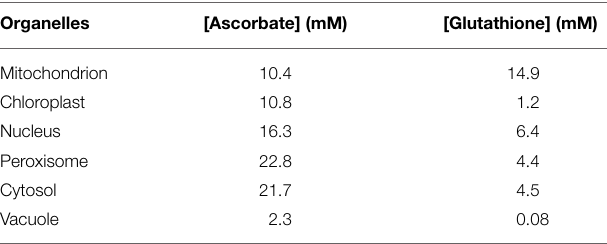
The intracellular AsA and GSH levels in young rosette leaves of Arabidopsis thaliana plants determined using AsA and GSH specific immunogold labeling (Gest et al., 2013; Zechmann,